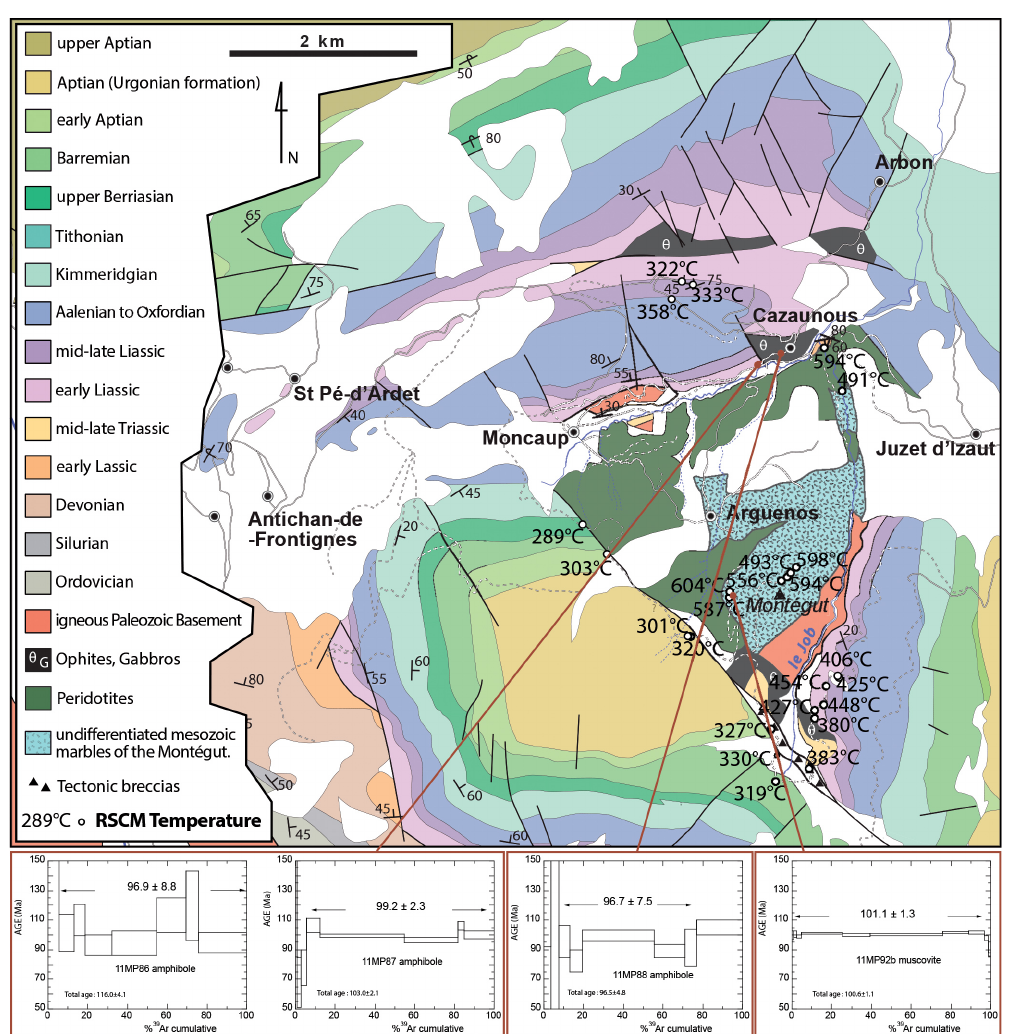
Figure 7. Geological map of the Arguenos–Moncaup area (after Barrère et al., 1984a; Hervouët et al., 1987; Canérot and Debroas, 1988) with Raman temperature values and location of the samples used for 40 Ar– 39 Ar dating. A clear increase of peak temperature appears in the vicinity of the mantle